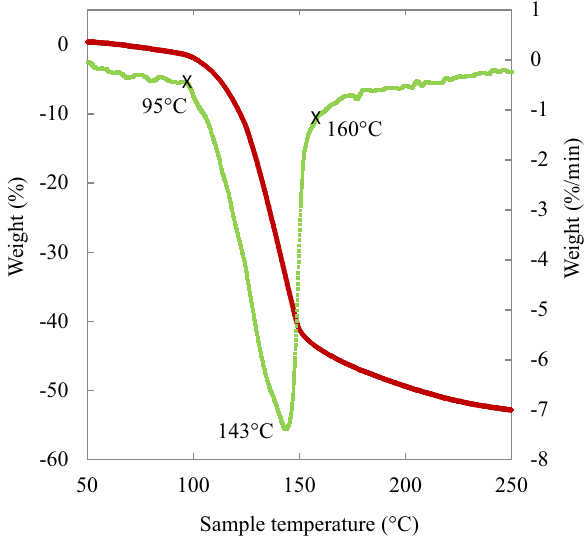
Fig. 17 The TG (red line) and DTG (green line) curves of the THDA